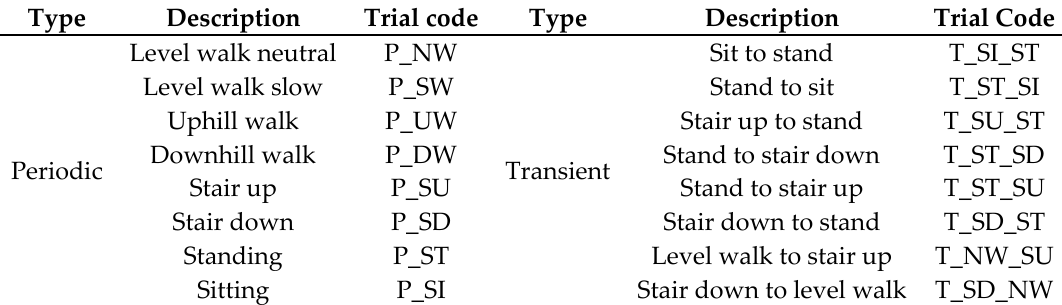
Table 1. Gait tasks collected in the database, together with their